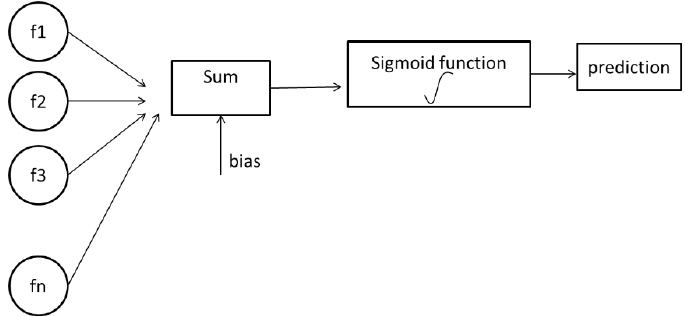
Figure 1. Visualization of logistic regression steps.